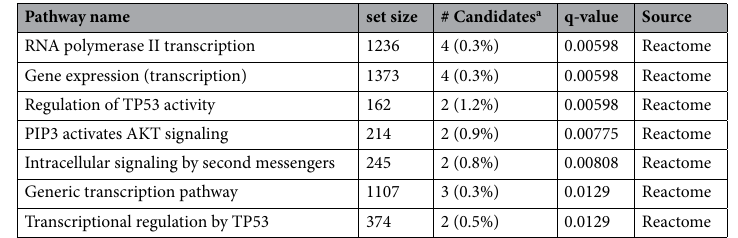
Table 4. Significant pathways associated with ARDS mortality using the Overlap gene approach . a Numbers of genes in the pathway are from the 10 genes identified through the Overlap gene